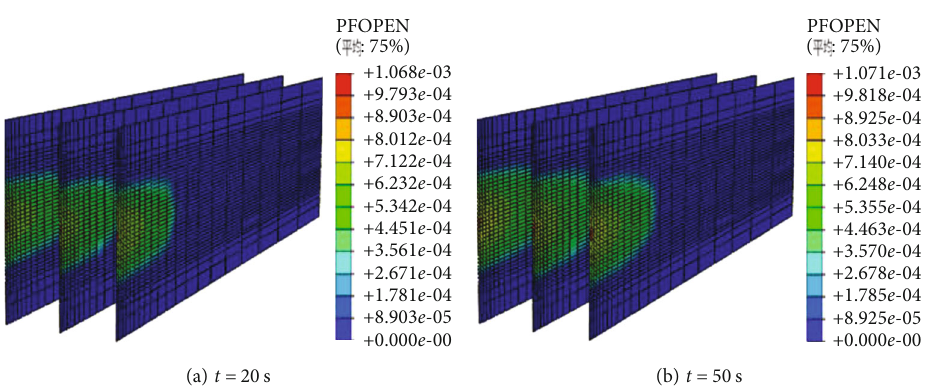
Figure 20: Fracture geometry after pumping for 50 s for di ff erent injection rates: (a) case 6 (8 m 3 /min); (b) case 7 (10 m 3 /min).